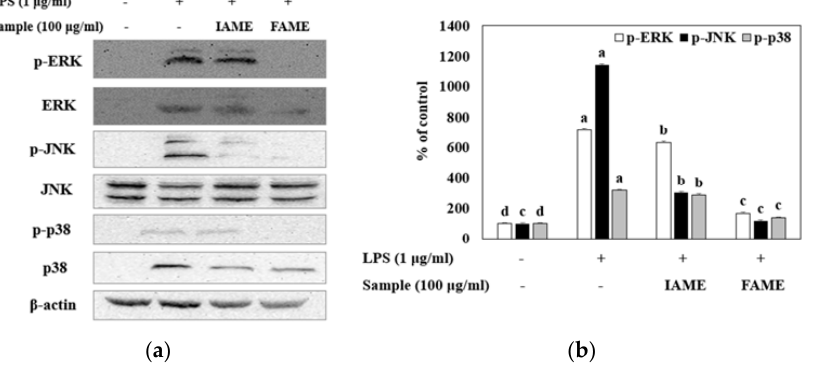
Figure 9. Effect of IAME and FAME on lipopolysaccharide (LPS) ‐ stimulated MAPK signaling path ‐ way. Raw264.7 cells were pretreated with IAME and FAME (100 μ g/mL) for 2 h and then stimulated with LPS (1 μ g/mL) for 20 h. Equal amounts of cell lysates (30 μ g) were subjected to electrophoresis and analyzed for p ‐ ERK1/2, ERK1/2, p ‐ JNK, JNK, p ‐ p38, and p38, expression by performing West ‐ ern blotting. Actin was used as an internal control. ( a ) p ‐ ERK1/2, ERK1/2, p ‐ JNK, JNK, p ‐ p38, and p38 protein expression. ( b ) Expression levels of p ‐ ERK1/2, p ‐ JNK, and p ‐ p38. ( c ) Expression levels of ERK, JNK, and p38. Each value is expressed as the mean ± SD ( n = 3). a–d Values with different letters are different at p < 0.05, as analyzed by Duncan’s multiple range test. IAME, Abelmoschus manihot extract; A. manihot extract fermented by Bacillus licheniformis CP6.